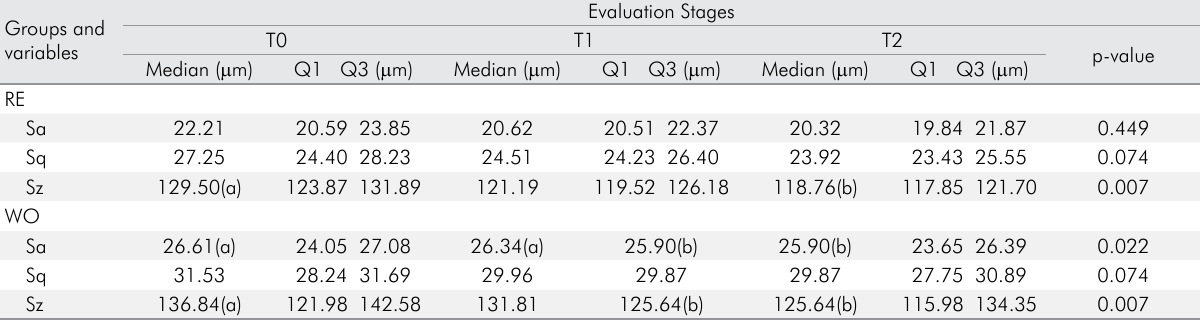
*Medians with different letters are significantly different (p < 0.05). Table 2. Comparison of groups Reciproc and WaveOne between times T1-T0, T2-T0 and T2-T1 by the analysis of the parameters Sa, Sq and